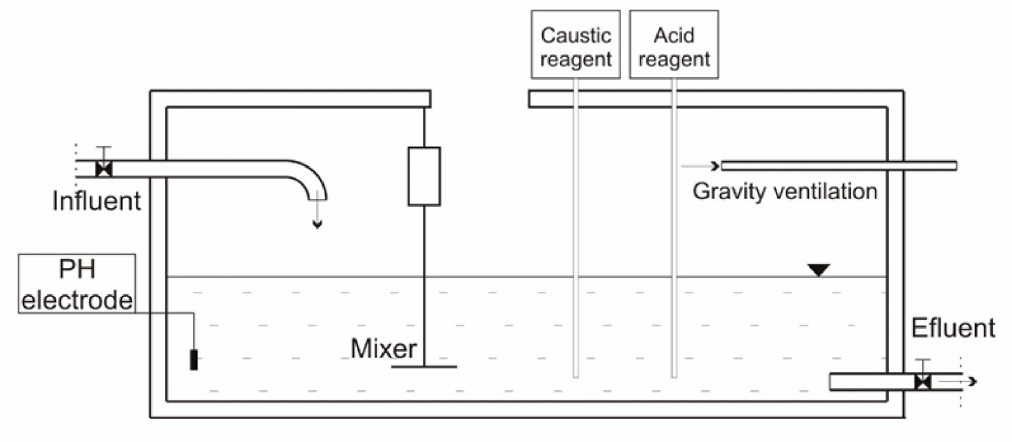
Figure 1. Method diagram of the neutralisation process in the concrete